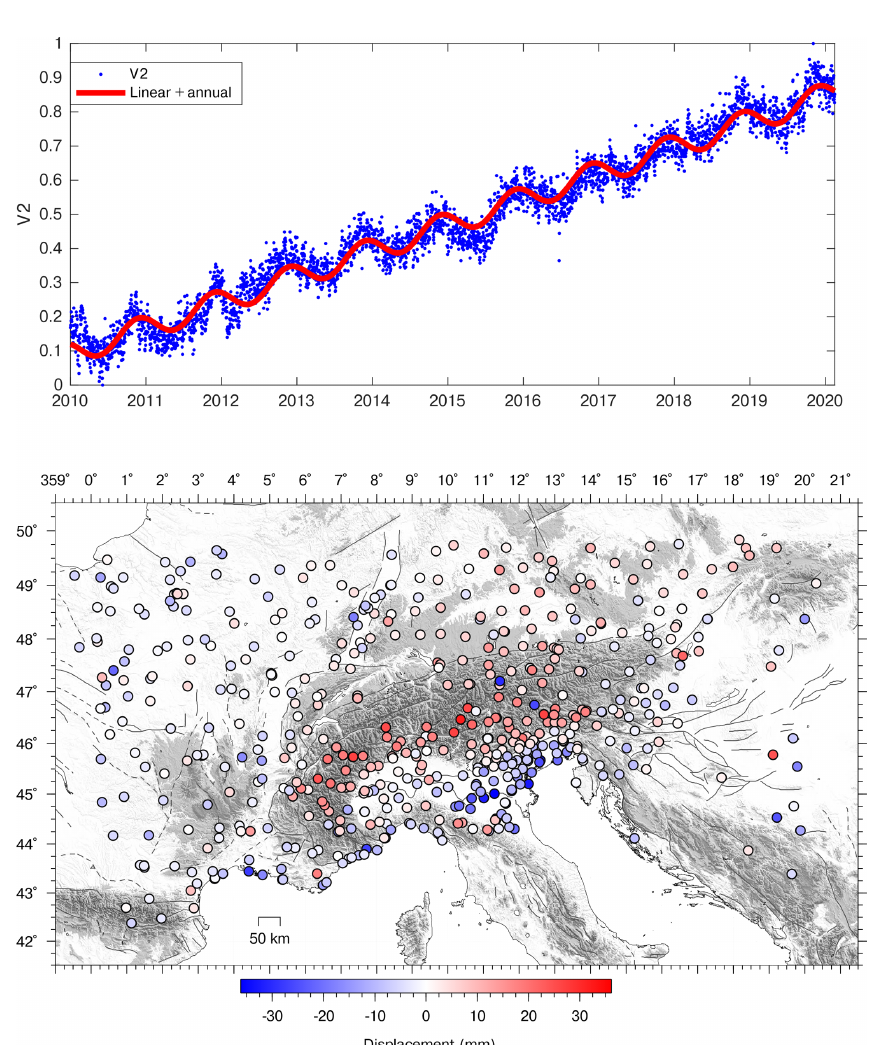
Figure 2. Temporal evolution and spatial response of the IC2 of the GNSS decomposition. Time series have been corrected only for instru- mental